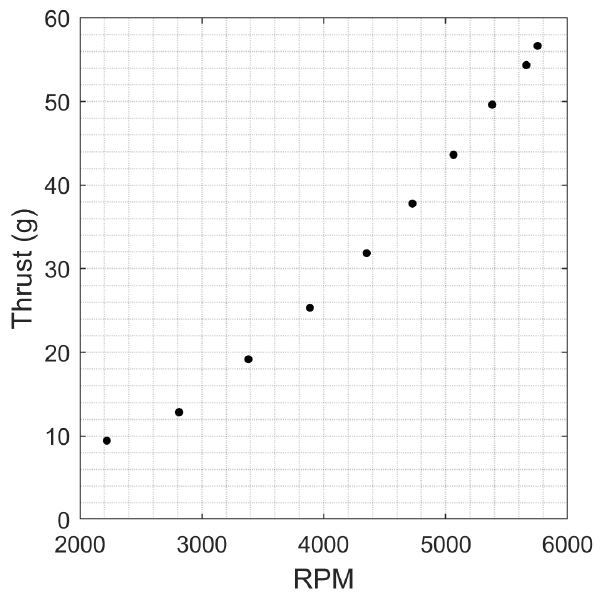
Figure 2. Thrust vs.